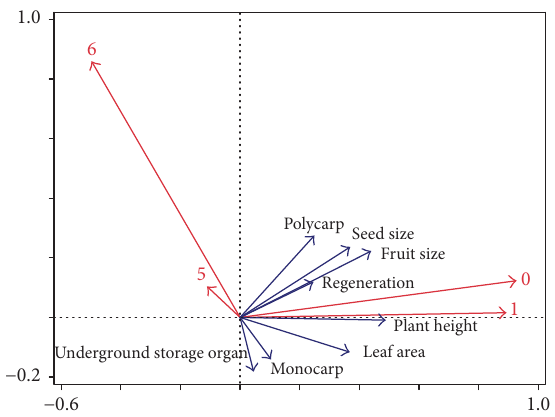
Figure 1: Redundancy analysis of the central weighted means of nineselectfunctionaltraitsofspeciesfoundwithintheNewEngland Batholith. Increasing number indicates increasing restriction to the inselberg environment (Table